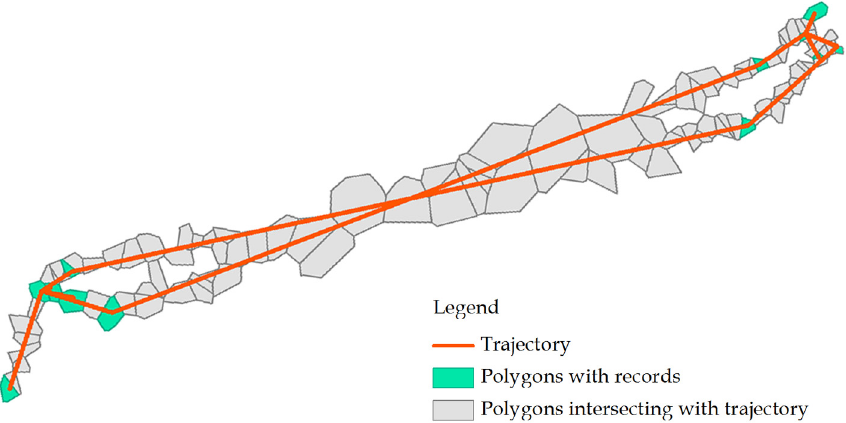
Figure 1. An example of one user’s trajectory. Clearly, most of the Voronoi tessellations that intersect the trajectory are not recorded.